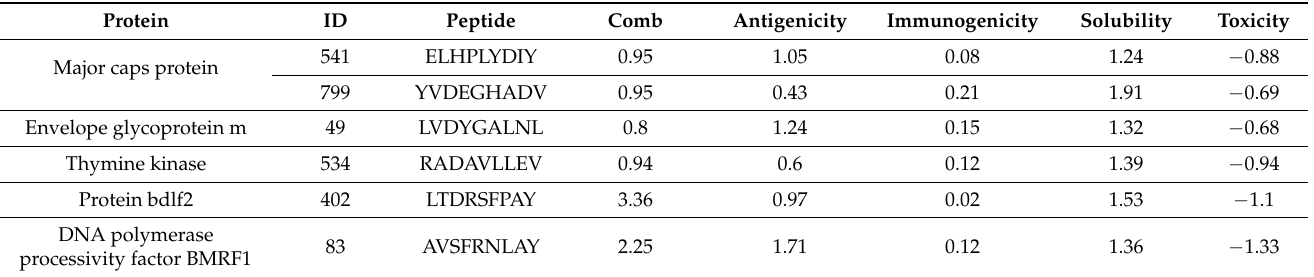
Table 2. Selected CTL epitope with respective binding affinity and physiochemical characteristics.